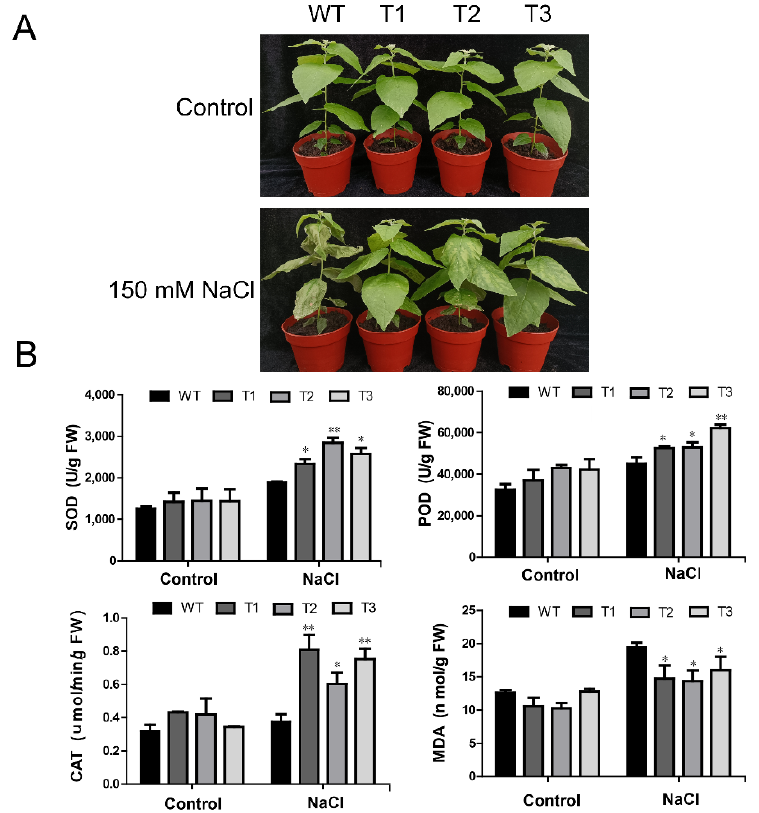
Figure 7. Morphological and physiological characteristics of transgenic poplars under salt stress. ( A ) Morphological phenotypes of transgenic poplars. ( B ) Physiological indices of transgenic poplars; FW, fresh weight. Error bars indicate mean ± SD. Asterisks indicate significant differences between transgenic lines and wild-type lines ( t test, * p < 0.05; ** p < 0.01).